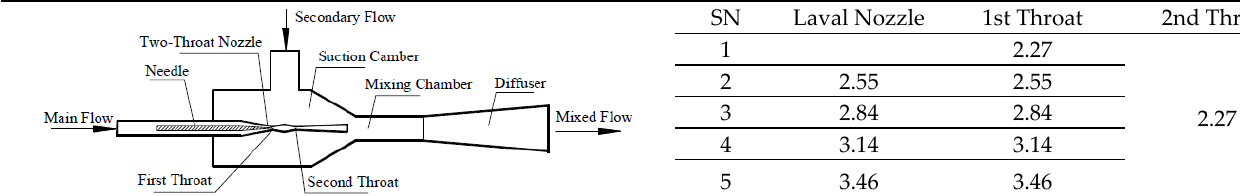
Figure 20. Schematic diagram of two-throat nozzle ejector with throat CSA (mm 2 ) [81].